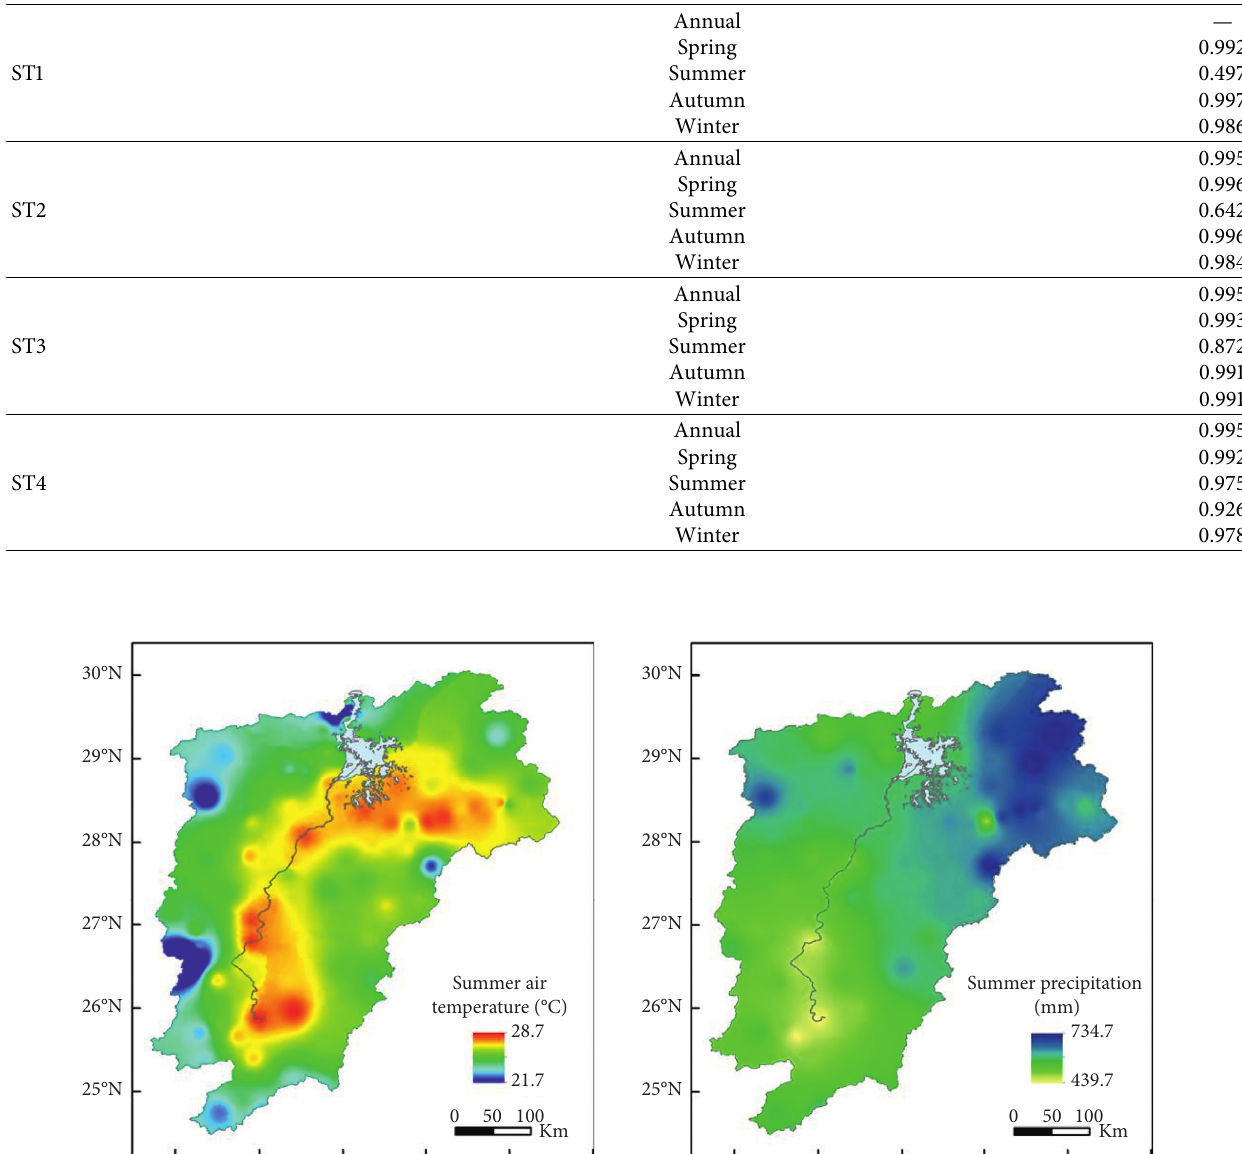
Table 4: Spatial correlation coefficient between annual ST1 and soil temperatures for other depths and time periods. Correlation